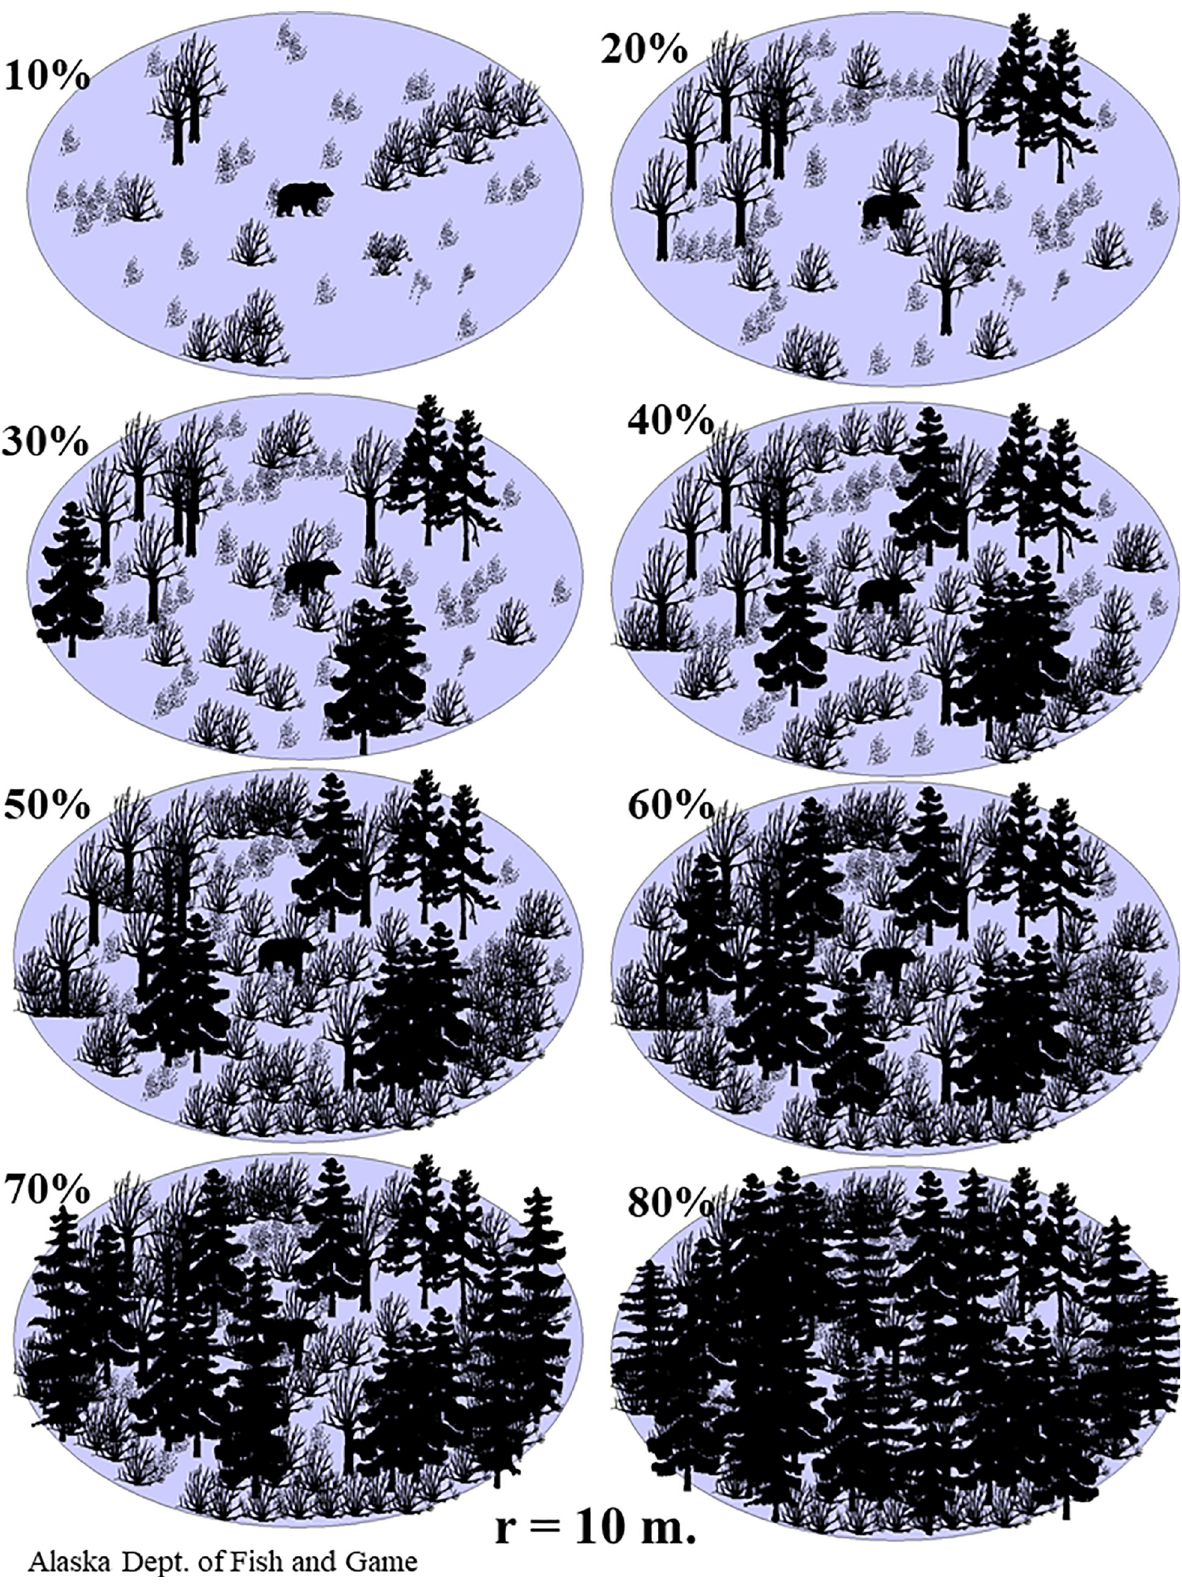
Fig 3. Reference sheet for percent cover and percent snow for a spring 2002 distance sampling survey of brown bears in southwestern Alaska.